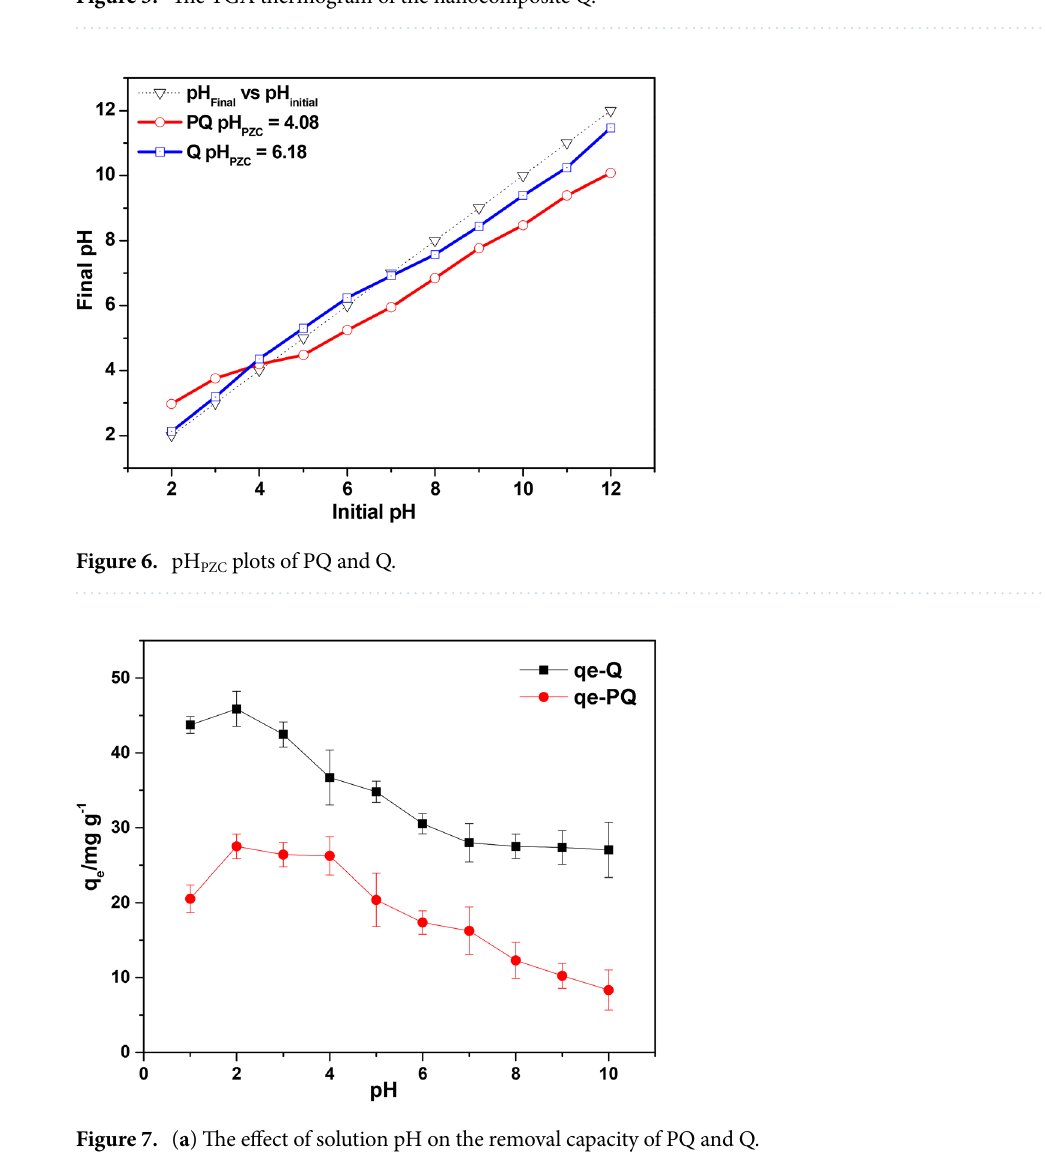
Figure 5. The TGA thermogram of the nanocomposite Q.